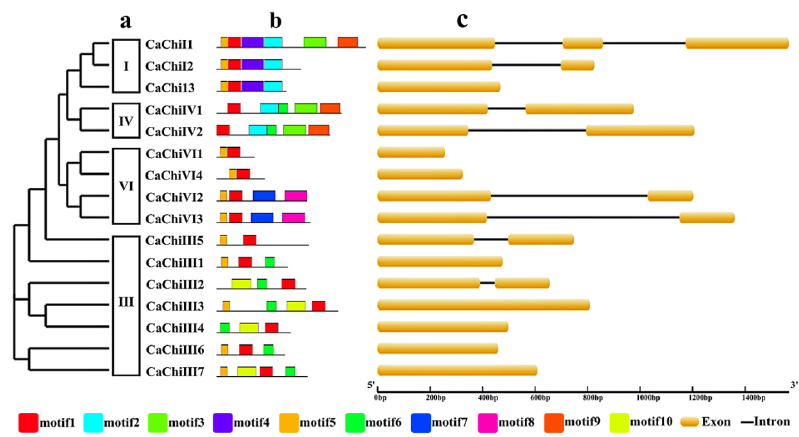
Figure 3. Phylogenetic relationship, domain organization and conserved motifs analysis of chitin- binding proteins family genes in pepper. ( a ) Phylogenetic analysis and classification of pepper genes.